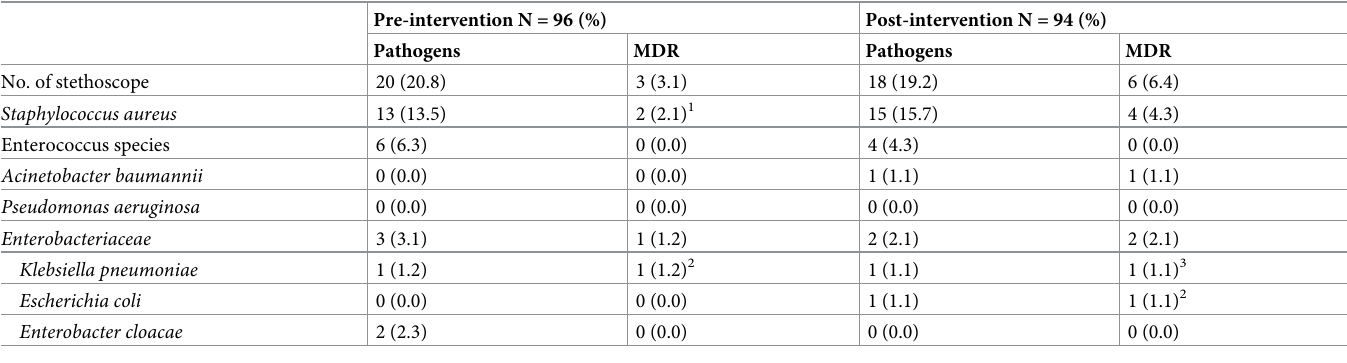
Table 3. Isolated nosocomial pathogens and proportion of MDR organisms.